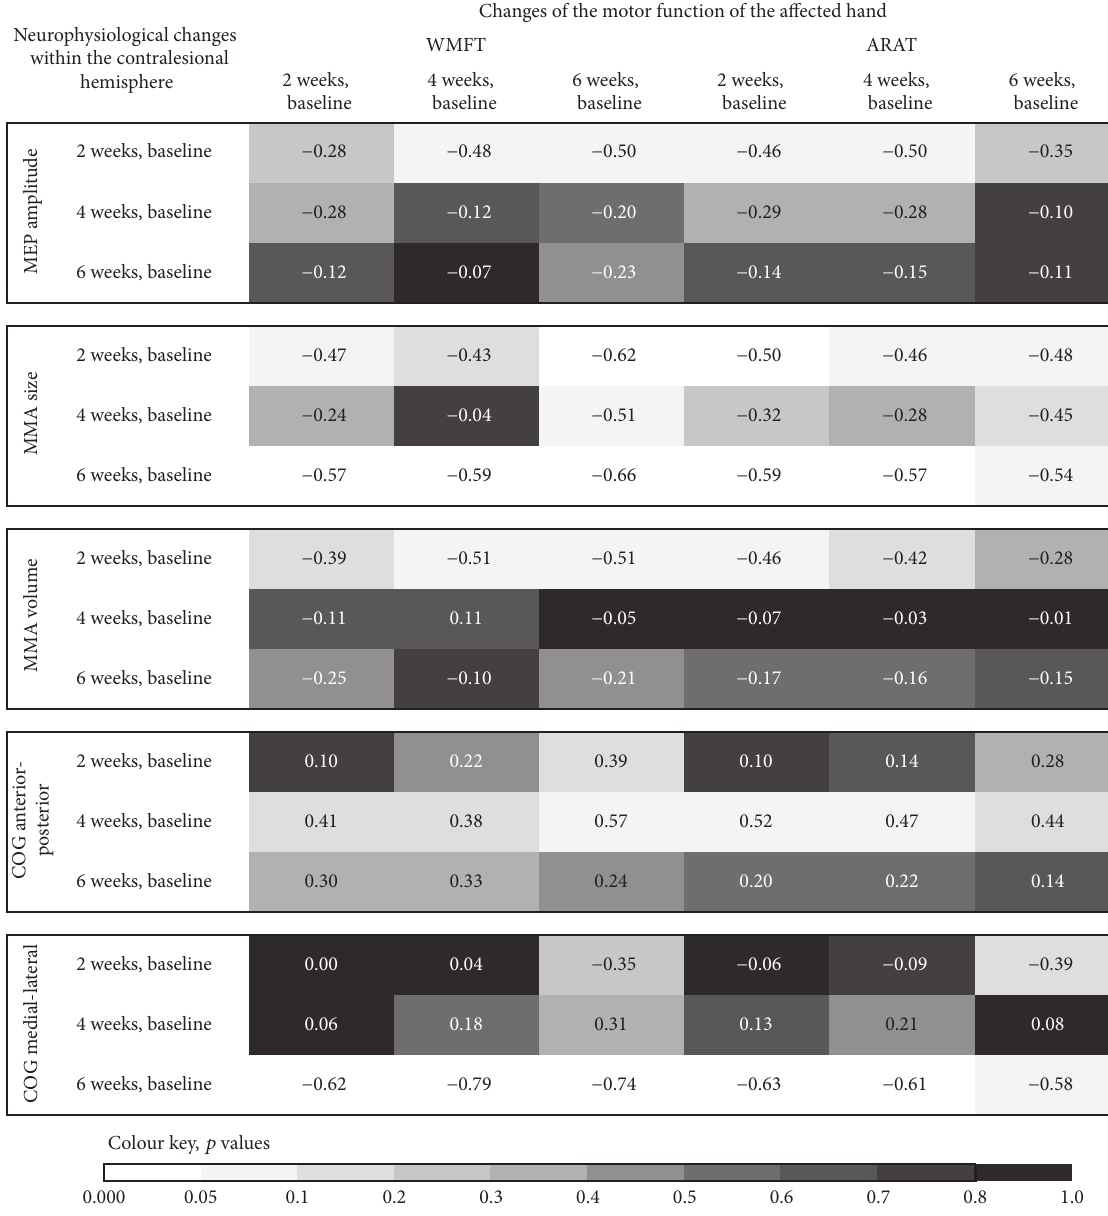
Figure 4: Correlation-coefficients between changes of neurophysiological values within the contralesional hemisphere and changes in motor function of the affected